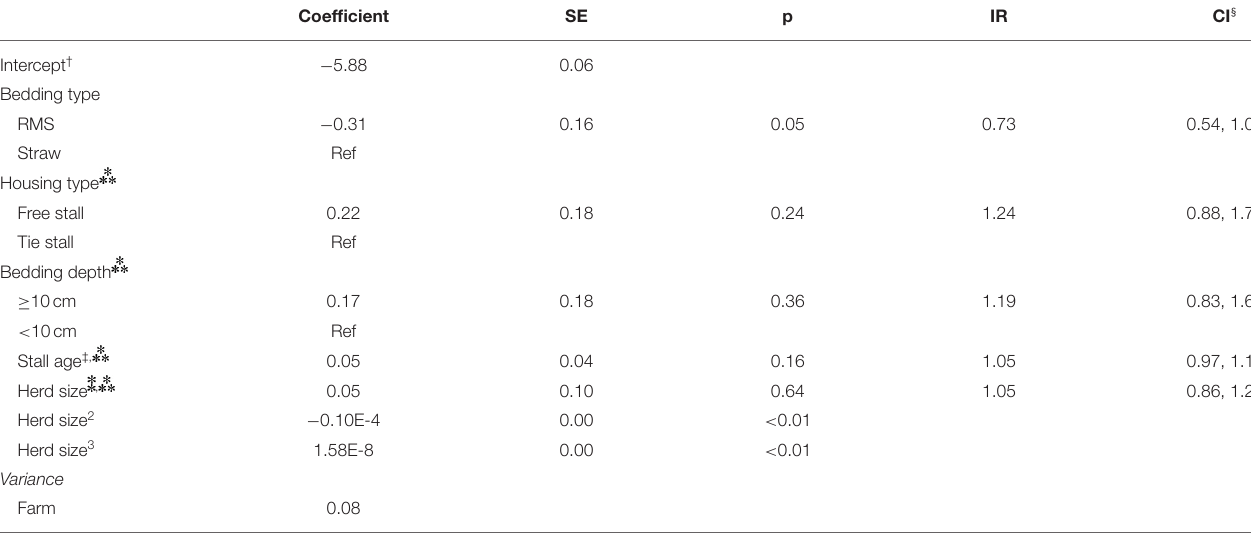
TABLE 4 | Risk of acquiring a new subclinical mastitis as function of bedding type estimated using a generalized linear mixed model applied to 43,546 pairs of DHI tests from 11,031 cows from 20 RMS farms and 60 straw-bedded